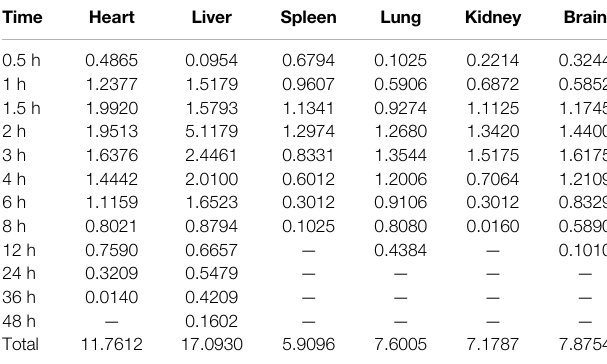
TABLE 5 | Concentrations of anwulignan in the different tissues of mice after the intragastric administration of anwulignan.